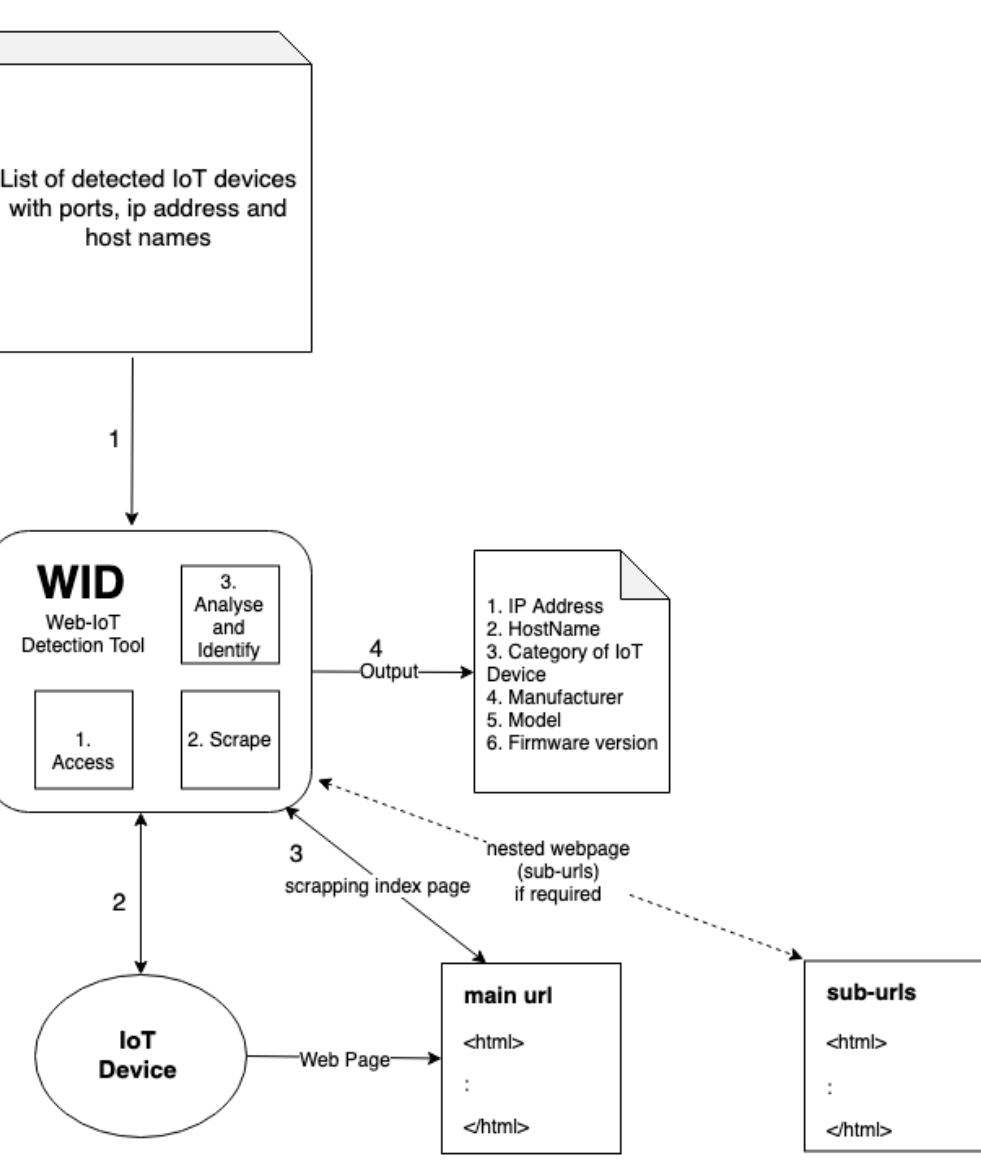
Figure 3. Overview of Web-IoT detection (WID)